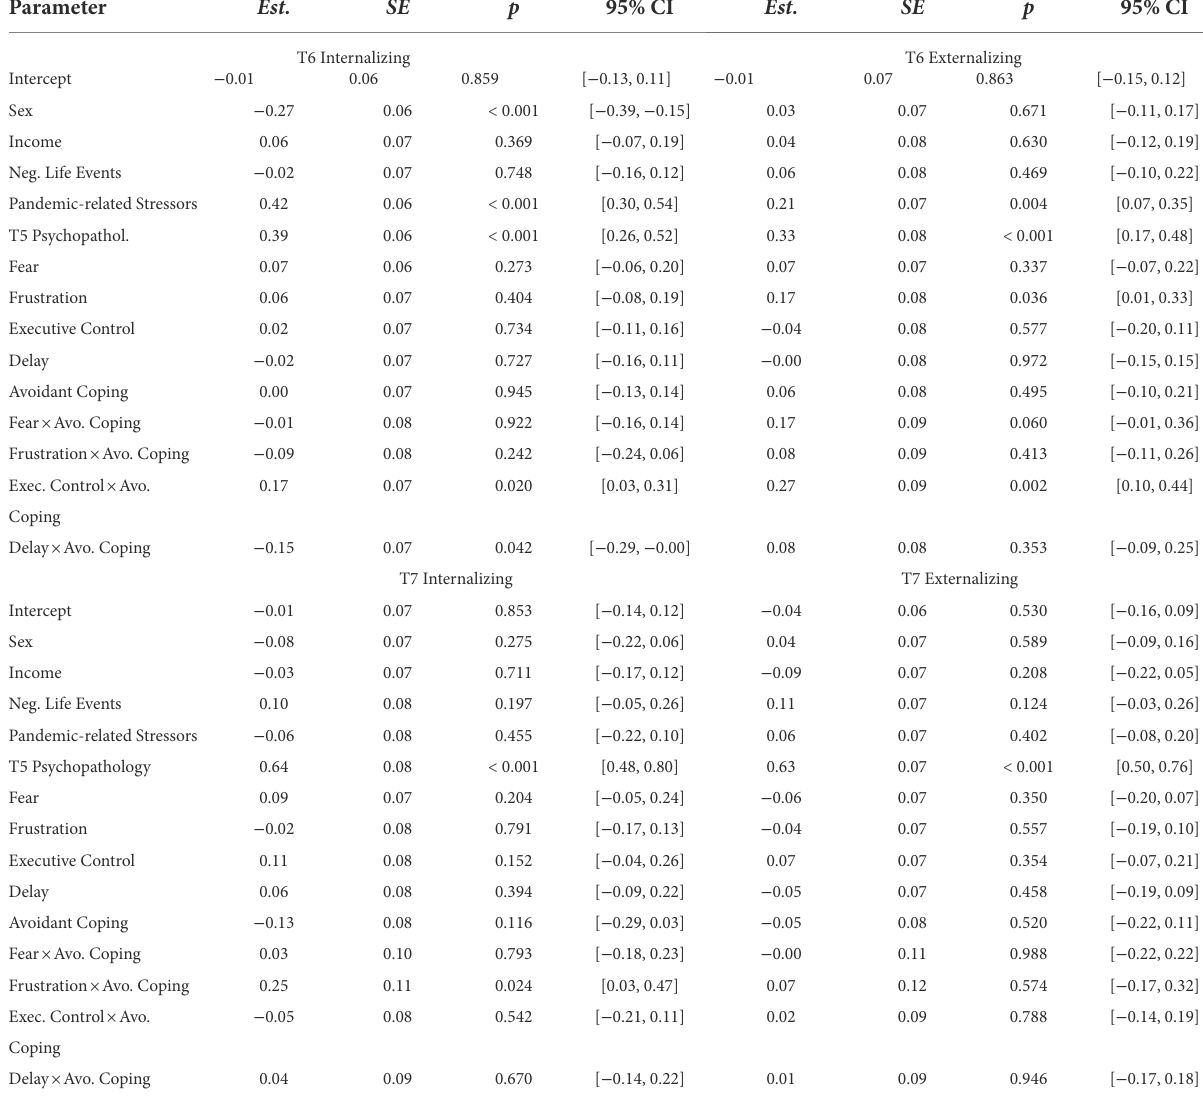
TABLE 4 Standardized regression coefficients, standard errors, and confidence intervals from regressions predicting adolescent psychopathology from temperament and avoidant coping. Parameter Est.